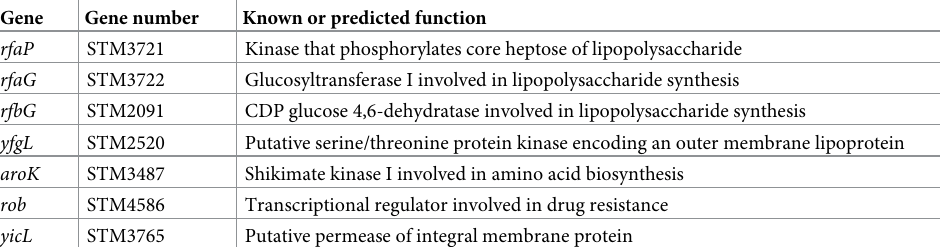
Table 3. Disrupted genes in the sodium dodecanoate susceptible mutants of S . enterica